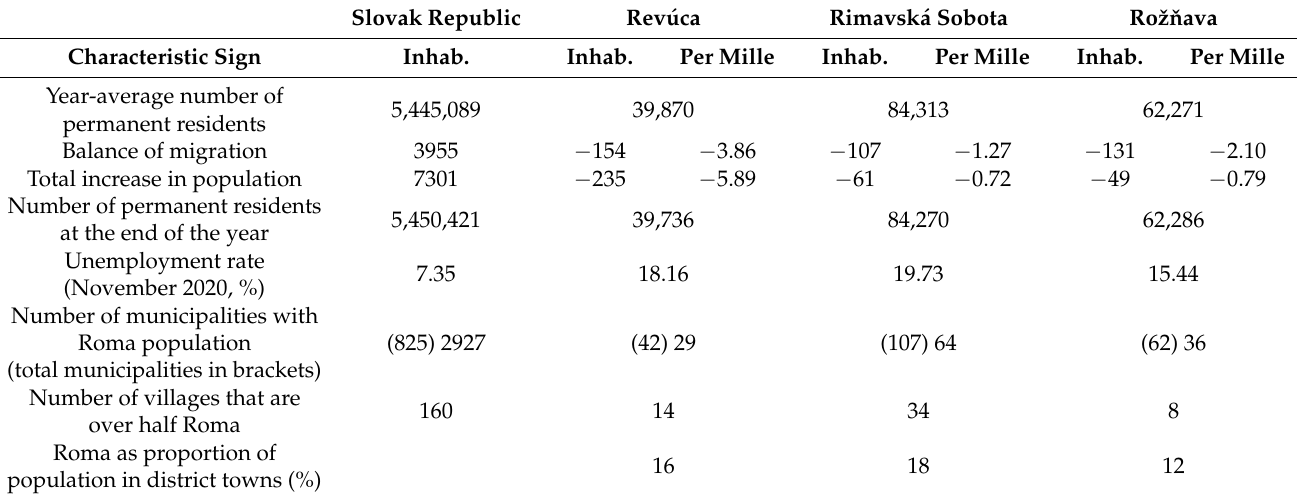
Table 1. Population data and trends in 2019 and